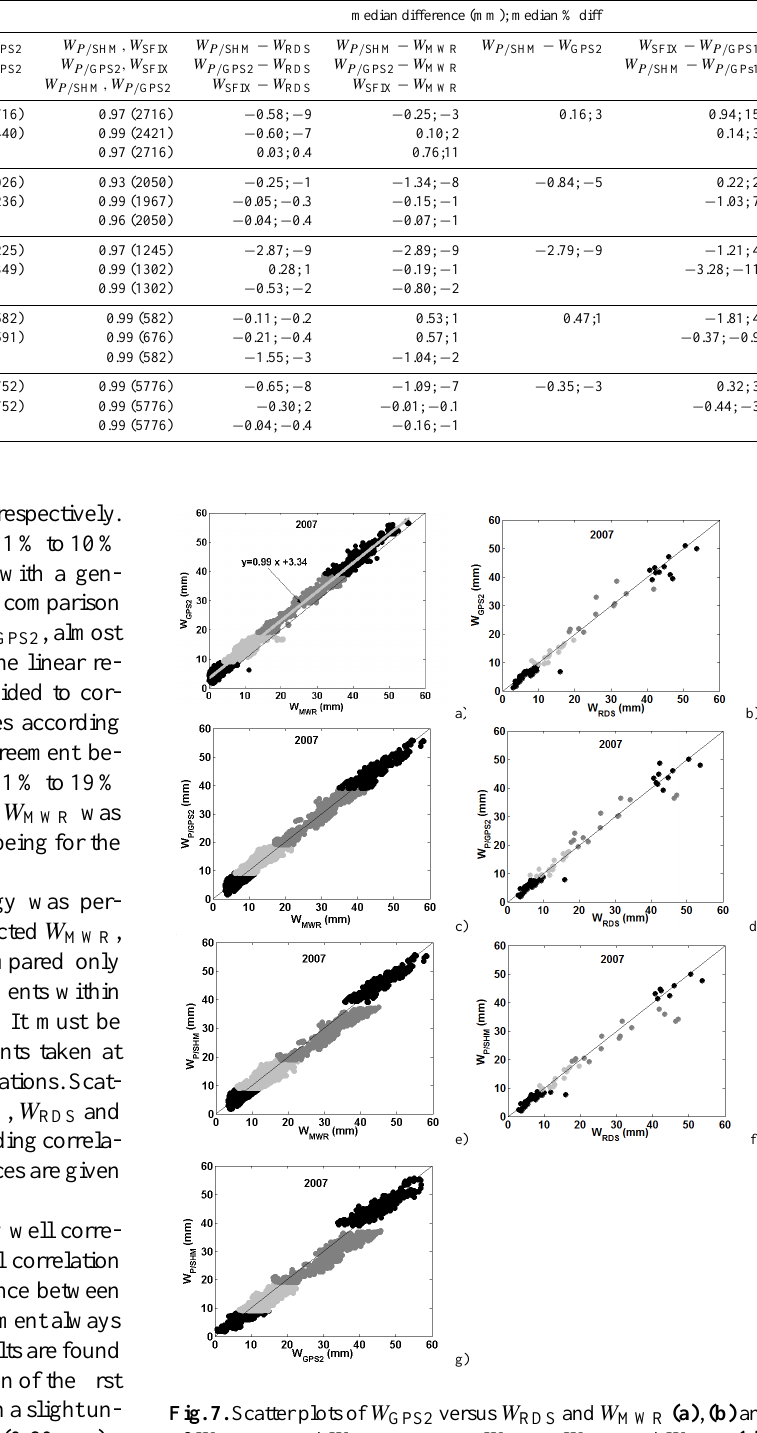
Fig. 7. Scatter plots of W GPS2 versus W RDS and W MWR (a) , (b) and of W P/ GPS2 and W P/ SHM versus W MWR , W RDS and W GPS2 (c) – (g) . Alternations of grey and black indicate the four water vapour